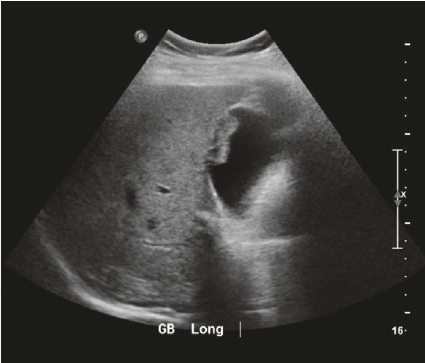
Figure 1: Ultrasound of the gallbladder demonstrating an irregular lesion along the gallbladder wall measuring 2.9 × 1.0 cm.